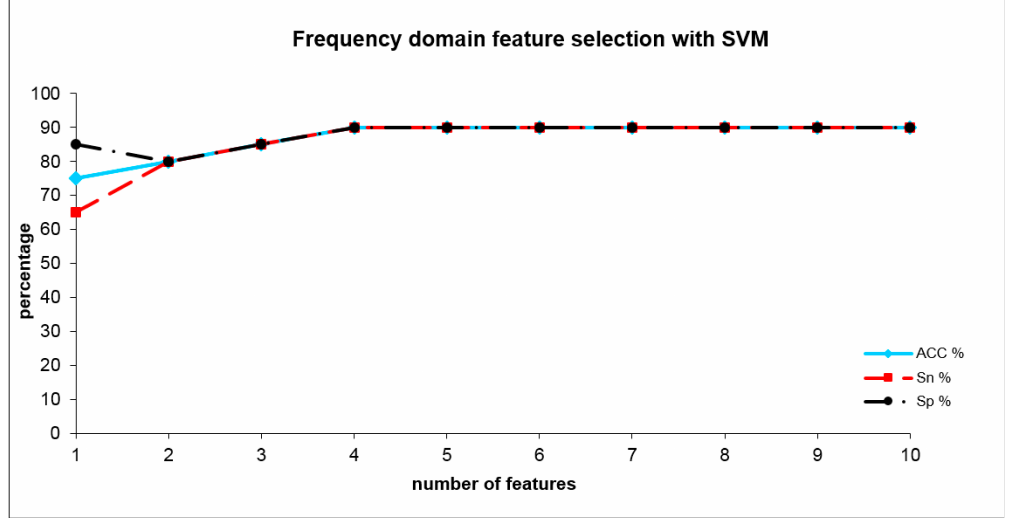
Figure 6. Accuracy, sensitivity and specificity using SVM analysis from frequency domain indices where the cannabis-users and tobacco-smokers group could be discriminated depending on the number of included optimum